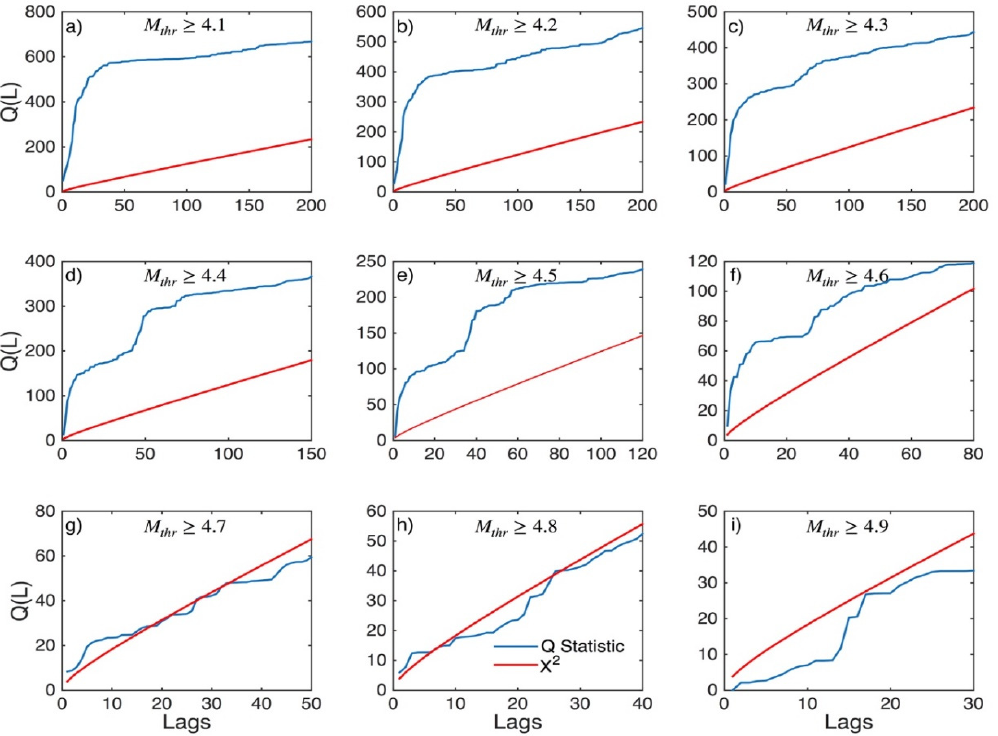
Figure A17. PACF values (orange stems) and their 95% confidence intervals (blue lines) for Corinth Gulf (sub − area 7) for magnitude thresholds ( M thr ) varying from 4.1 to 4.9 (subplots a – i ).